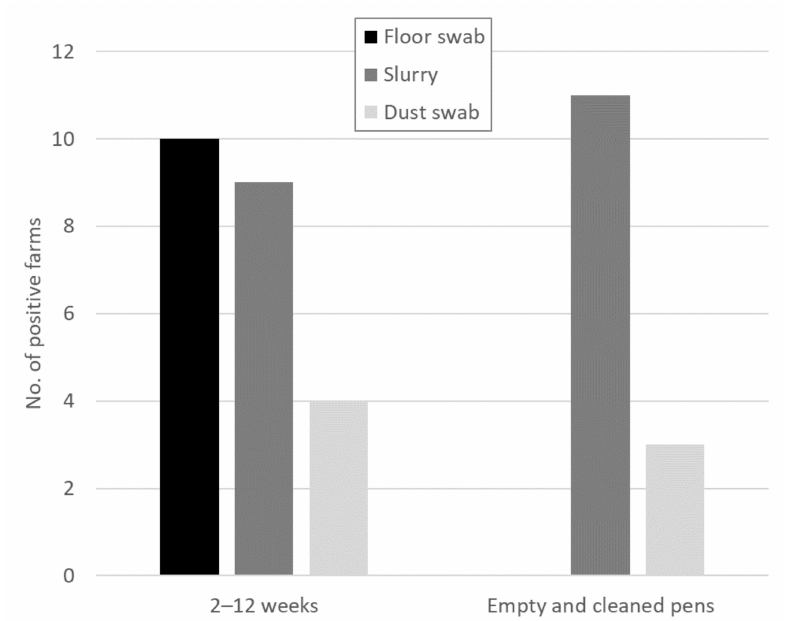
Figure 1. Summary of the results from the different sample types from 14 farms with HEV-positive samples at different time points. Samples were taken from farms with pigs aged 2–12 weeks and from empty and cleaned pens at the end of the fattening phase.